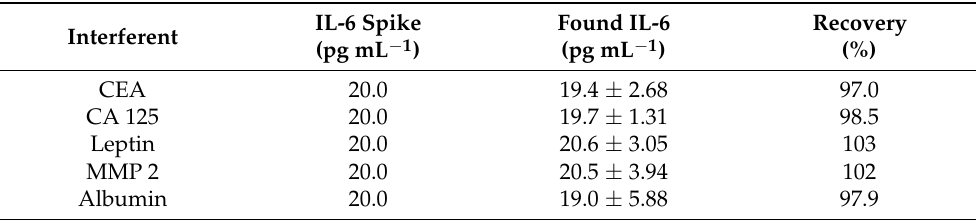
Table 1. Influence of excess of human albumin, leptin, CEA, CA-125 and metalloproteinase-2 (1000:1) on the results of determination of IL-6 concentration by the biosensor with antibody as the receptor (biosensor (a)).